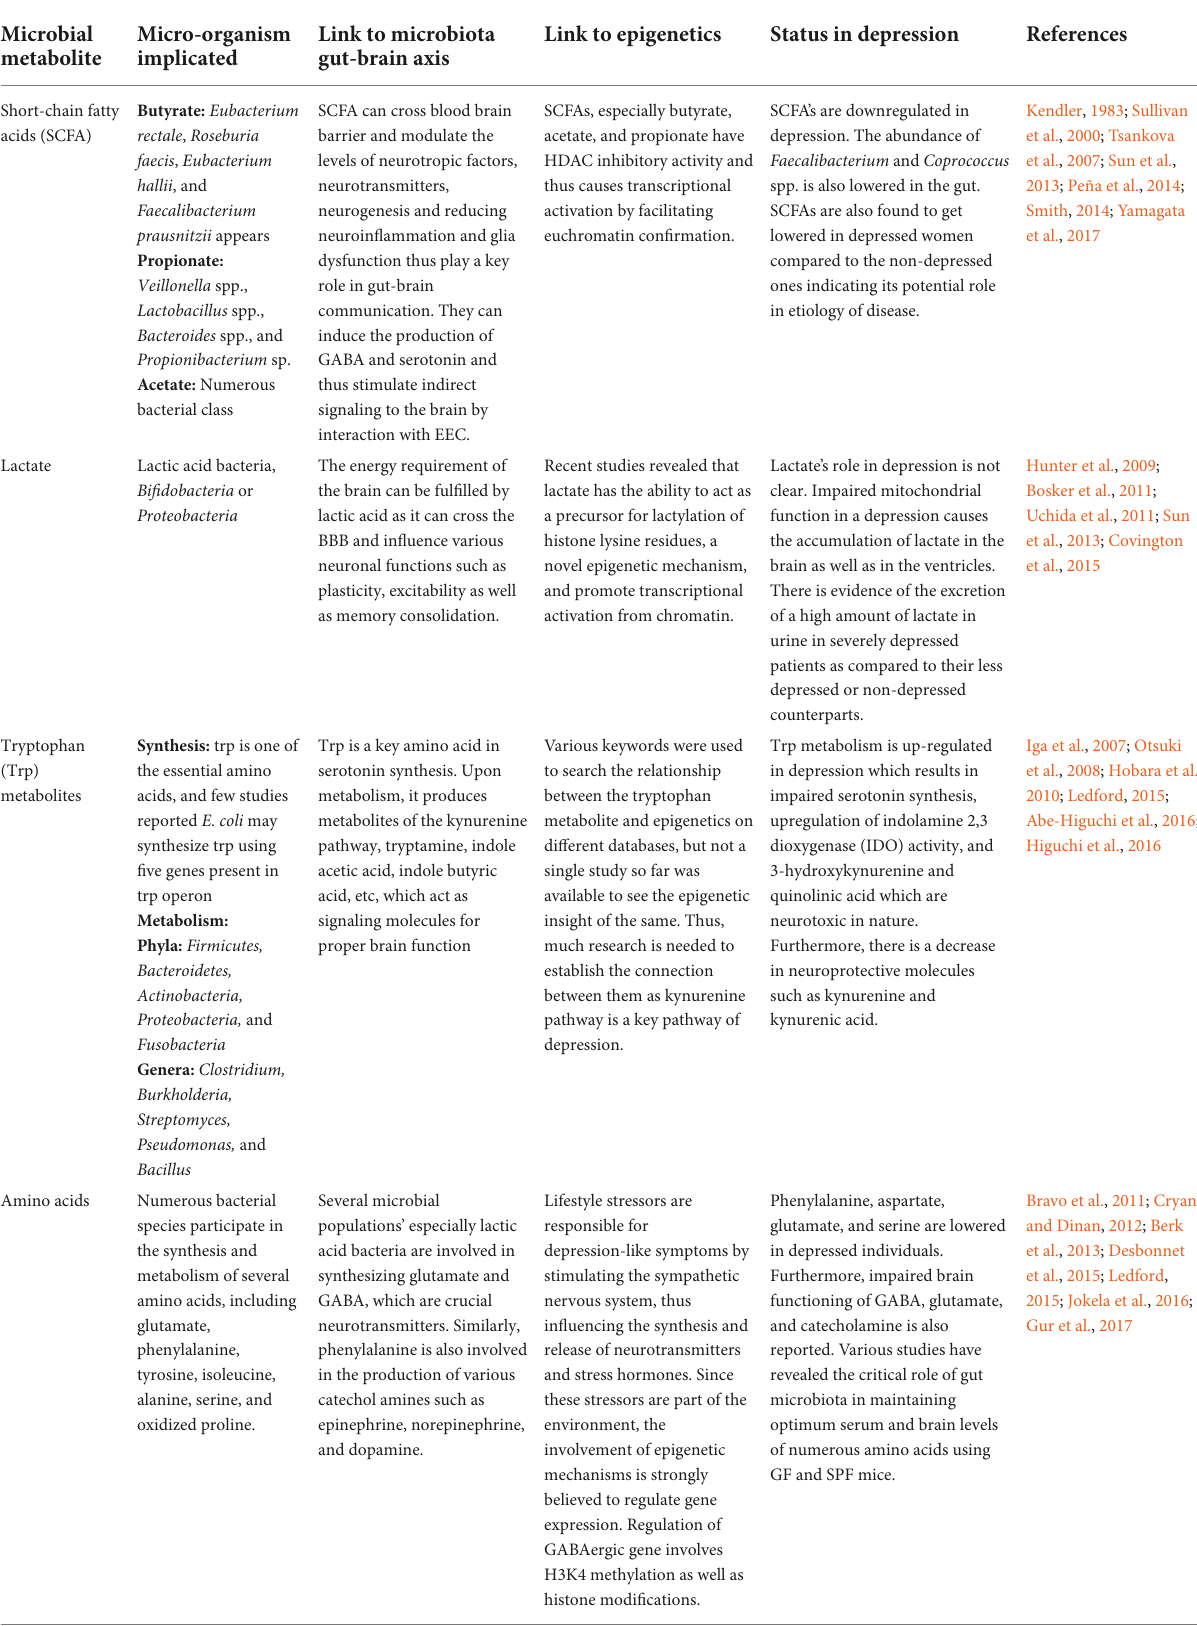
TABLE 3 Interplay between the GBA and epigenetics in